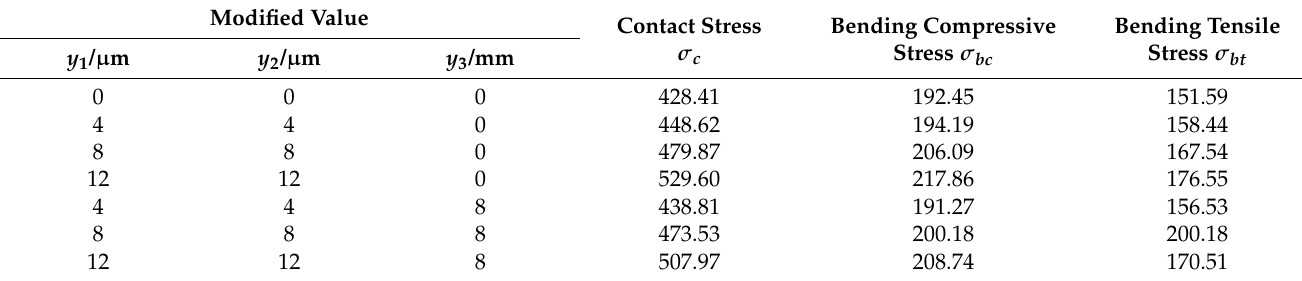
Table 3. Maximum stress of novel gears with different modified values (MPa).